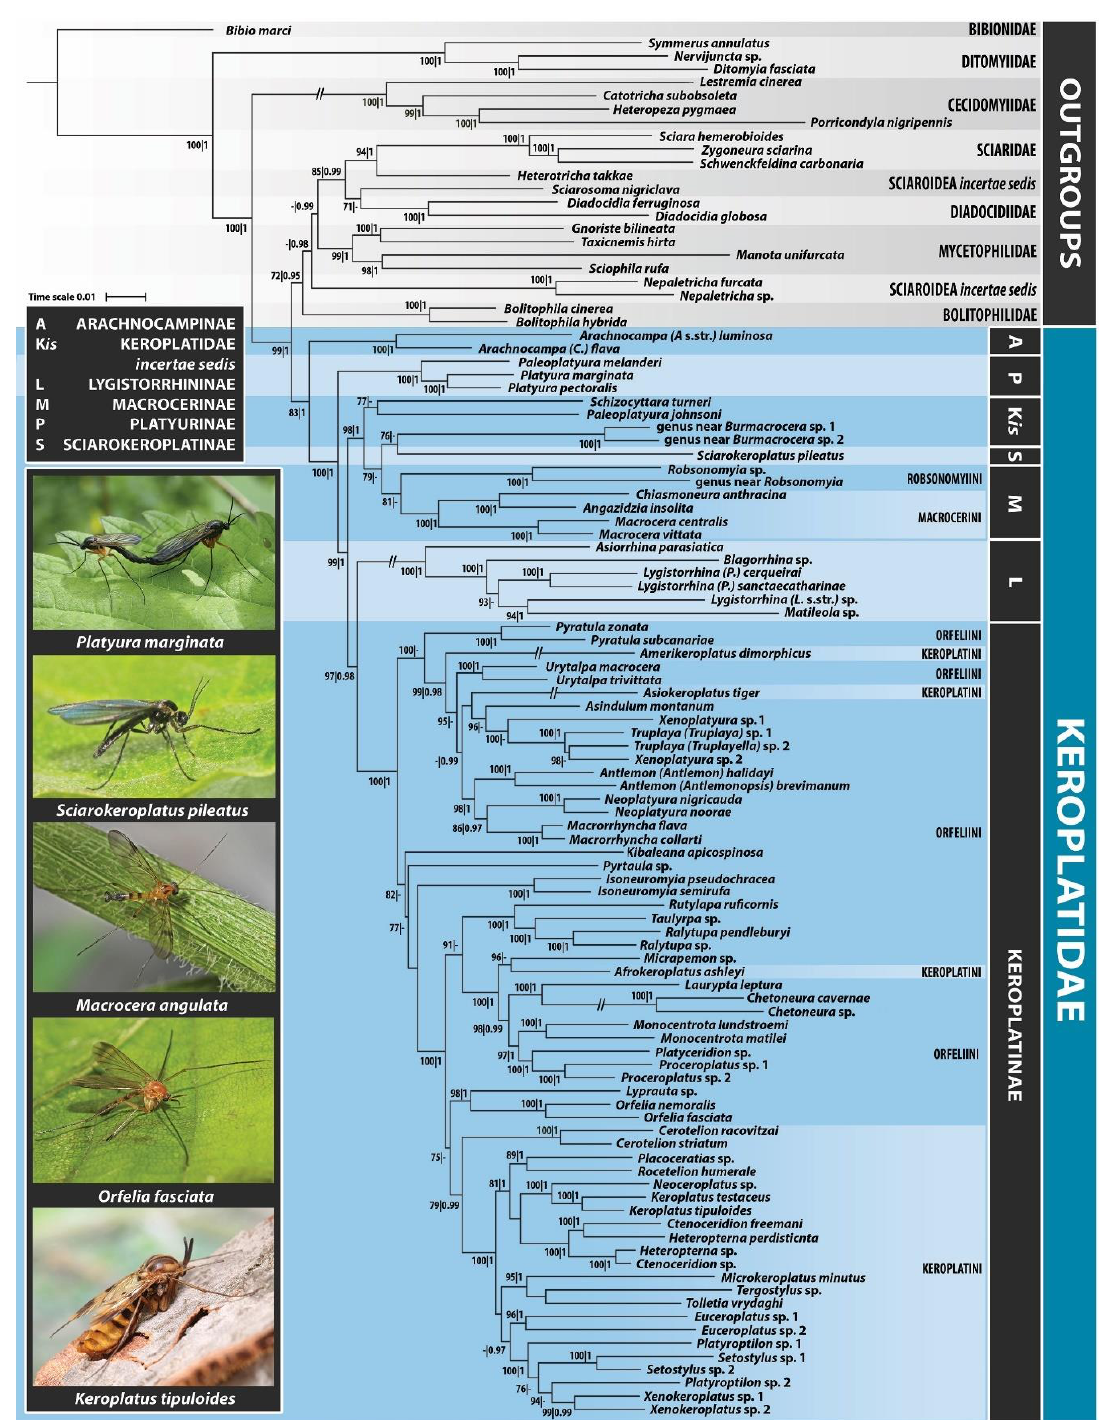
Figure 3. Maximum likelihood hypothesis for the family Keroplatidae based on the combined analysis of 105 taxa and 8 gene markers (12S, 16S, 18S, 28S, CAD, COI, cytb, MCS). Node support numbers refer to posterior probability (PP) over 0.95 and ultrafast bootstrap value (ufboot2) over